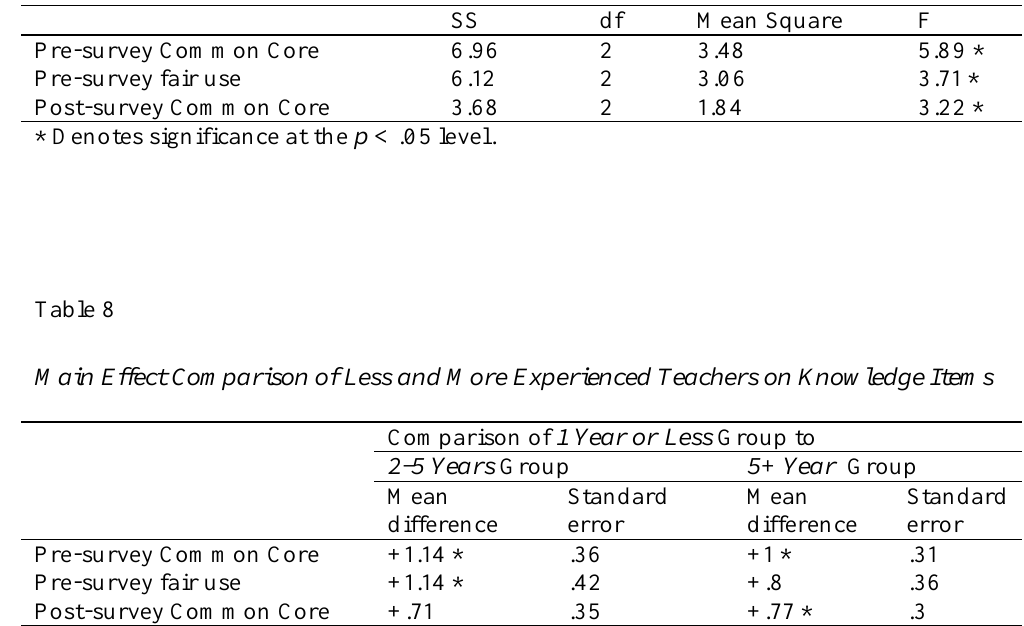
RQ5: Influences on Overall